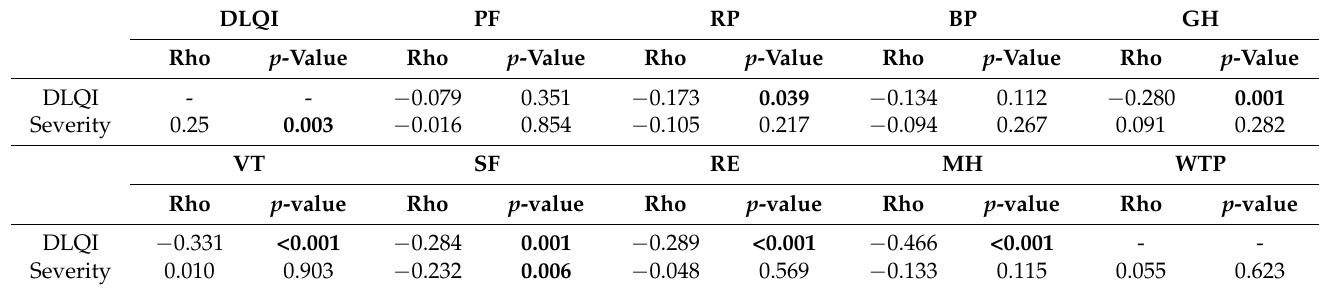
Table 3. Factors associated with QoL